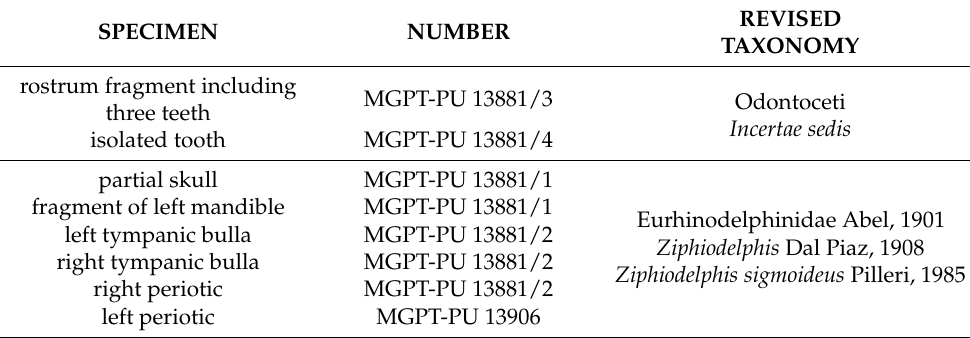
Table 1. Specimens studied in the present